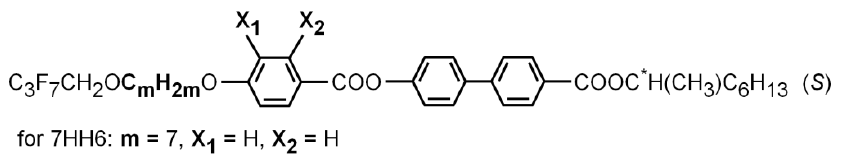
Figure 1. Molecular formula of mX 1 X 2 6 (m = 2–7; X 1 , X 2 = H or F).